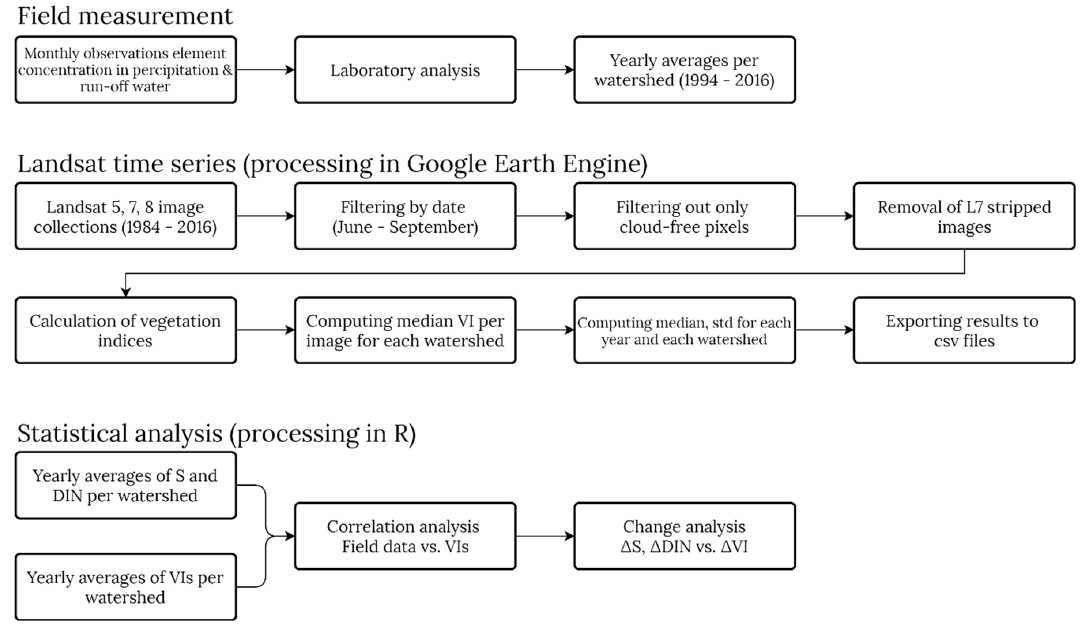
Figure 2. Field and image data processing workflow (VI – vegetation index, S – sulfur, DIN – dissolved inorganic nitrogen).